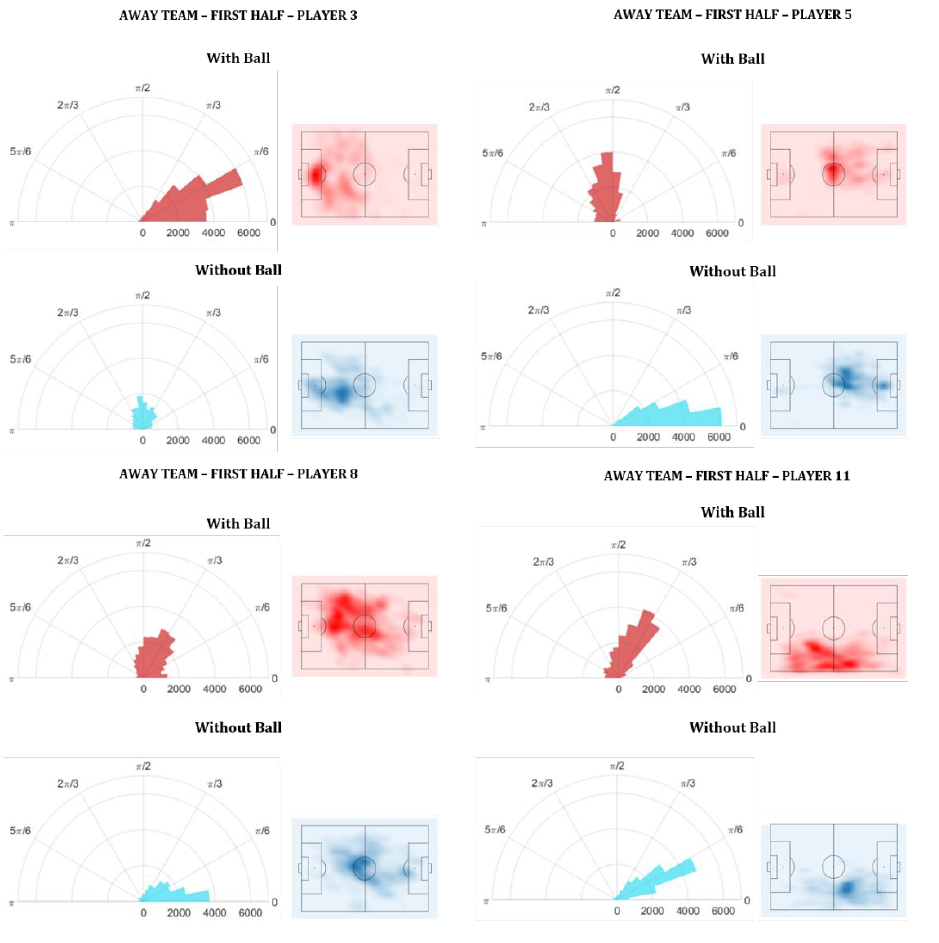
Figure 5. Relative frequency of the player-ball-goal angle (PBGA) illustrated by the polar graphs of four players of the away team in the roles with ball (red) and without ball (blue). The PBGA ranges from 0 to π . The relative frequency ranges from 0 to 7000 and can be seen on the bottom horizontal axis of each polar graph. To the right side of each player’s polar graph there is a heatmap of the respective player’s positions.